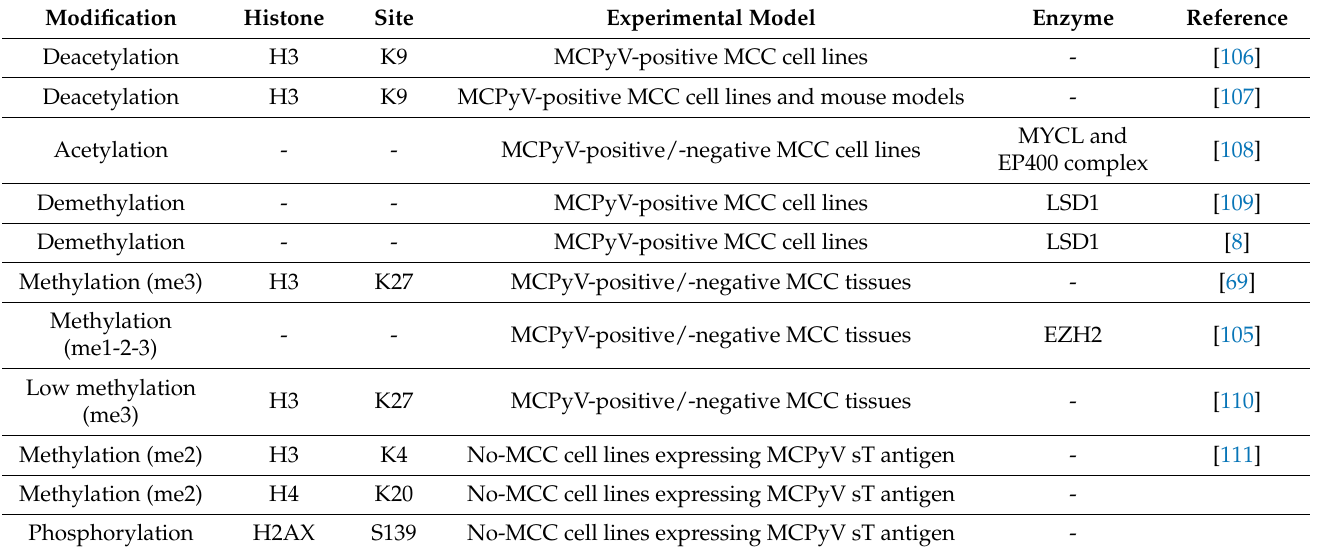
Table 1. Histone posttranslational modifications (HPTMs) and/or HPTMs modifying enzymes in Merkel cell polyomavirus (MCPyV)-positive Merkel cell carcinoma (MCC) tissues and/or MCPyV-positive MCC-derived cell